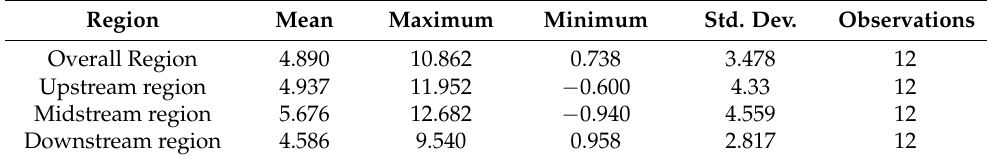
Table 3. Summary statistics of tfp in 4 regions.